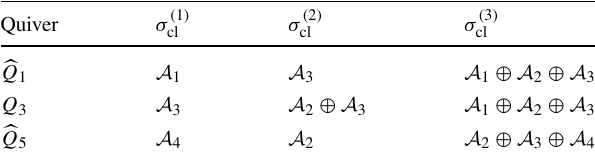
Table 5 For the quivers (cid:27) Q 1 , Q 3 and (cid:27) Q 5 drawn in Fig. 9, we list the classical expectation values of the twisted chiral fields in each of the 2d nodes, about which one finds the solution to the twisted chiral ring. Using this vacuum, along with the FI couplings in the classical twisted chiral superpotentials for each quiver, one finds identical expressions at leading order. The vacuum for the other quivers of the duality chain, namely Q 0 , Q 2 , Q 4 and Q 7 , can be read from Table 1